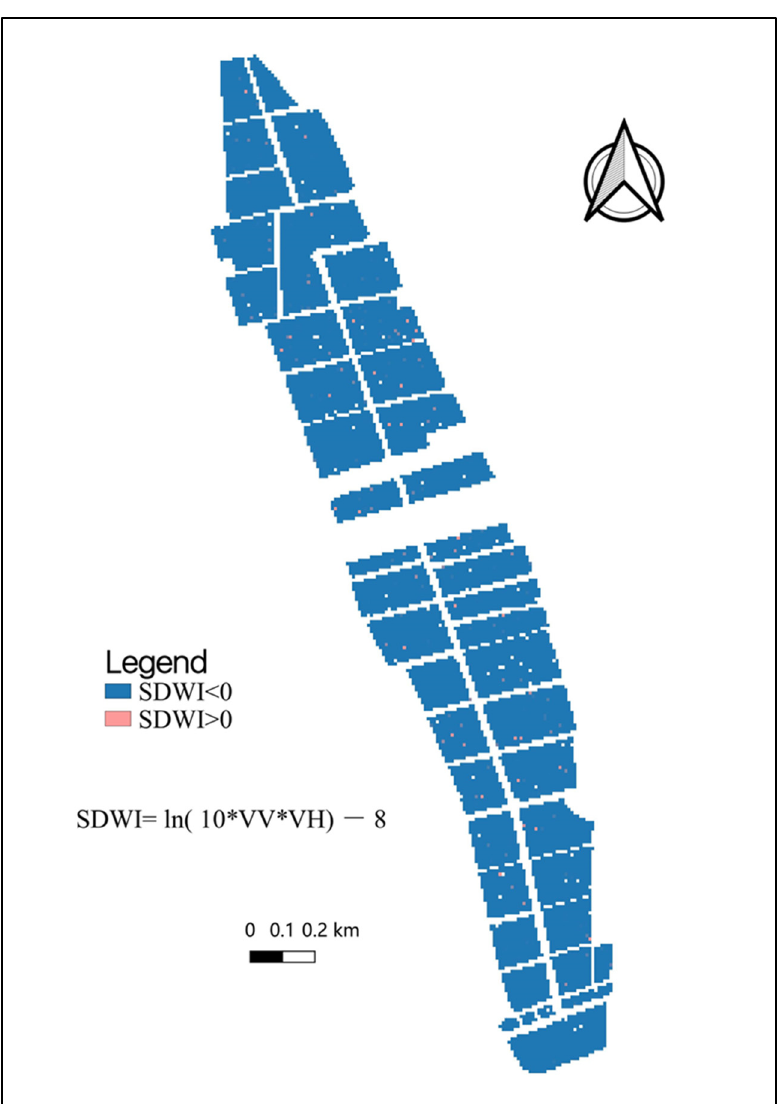
Figure A1. Dual - Polarized Water Index(SDWI) result. Figure A1. Dual-Polarized Water Index(SDWI)